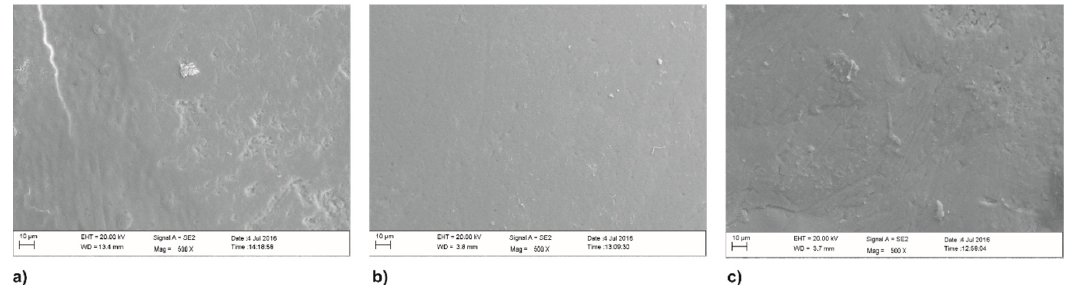
Figure 3. SEM microphotographs of the enamel surface. ( a ) untreated control surface, ( b ) after H 2/ O 2 sterilization, and ( c ) after O 2 sterilization. All three surfaces show a similar surface pattern within the biological range which is usually found in sound enamel.